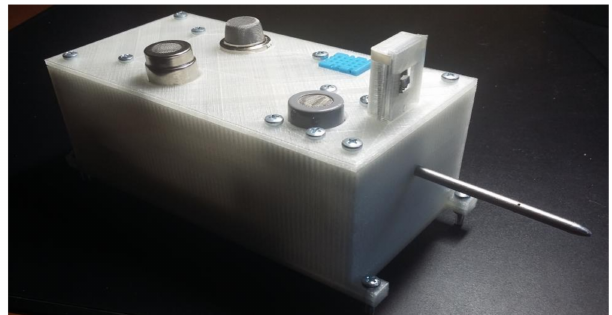
Figure 7. Environmental